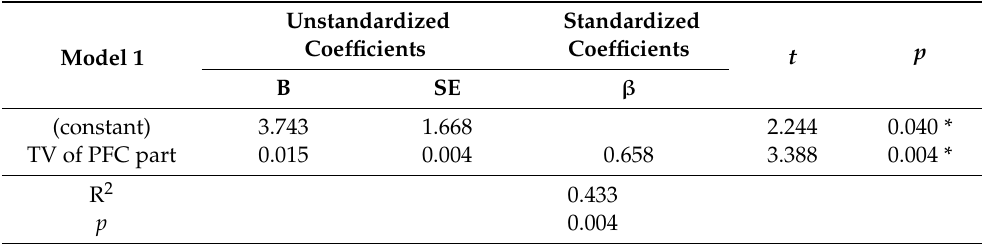
Table 3. Simple Linear Regression Analysis for the score of the Coma Recovery Scale-Revised and diffusion tensor tractography parameters for the thalamocortical